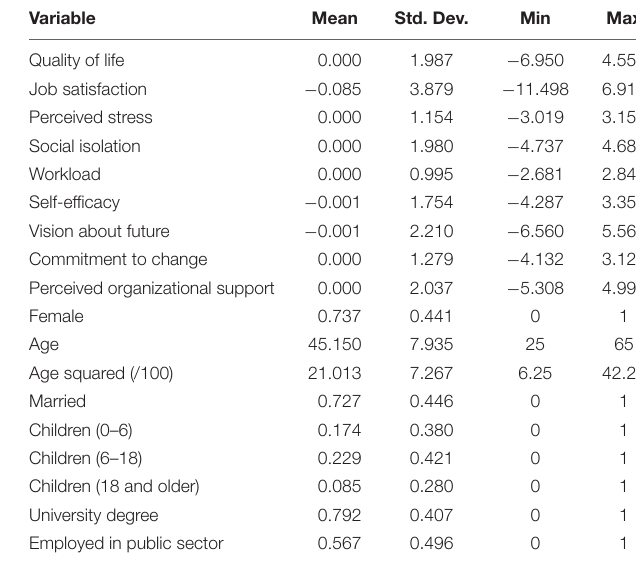
TABLE 3 | Summary statistics ( n =